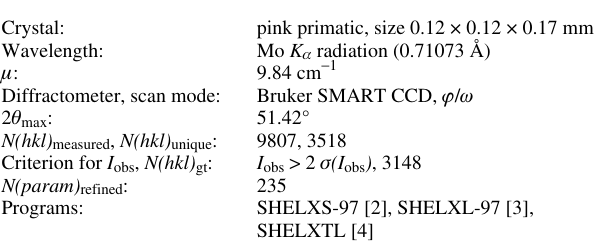
Table 1. Data collection and handling.